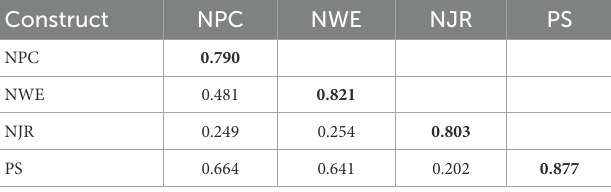
TABLE 4 Discriminant validity of the constructs—Fornell-Larcker criterion. Construct